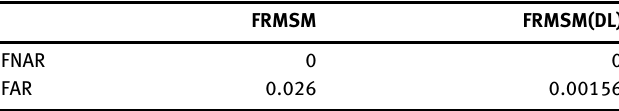
Table 2: Regular Minutiae Matching vs. Proposed Enhancement.